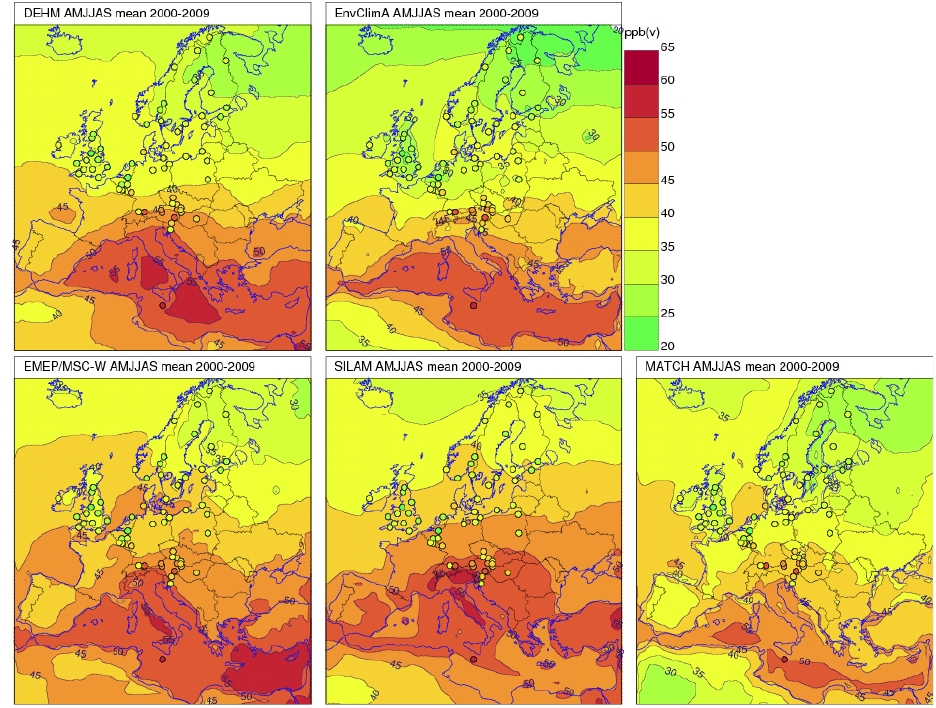
Fig. 7. Simulated April–September average O 3 concentration at the lowest model level for the period 2000–2009. Coloured circles indicate the observed values at the stations used in the model evaluation given in Table 3. Units